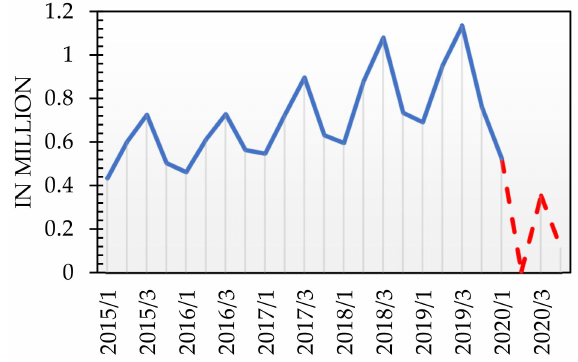
Figure 4. Number of passengers at Wrocław Airport.